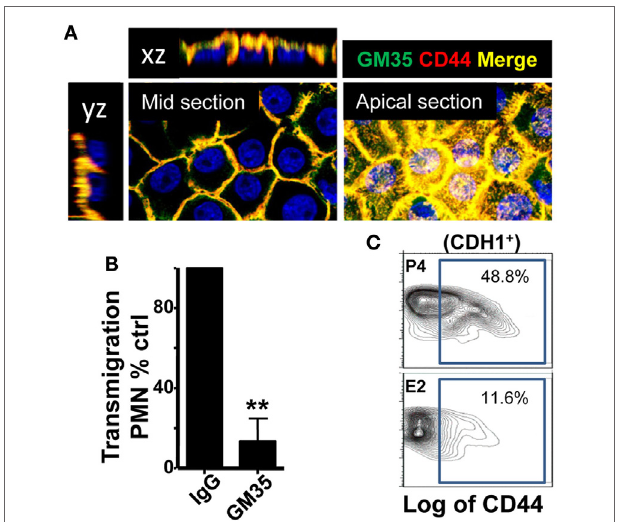
FigUre 7 | CD44 expression in the vaginal cells. (a) Confocal microscopy images of non-permeabilized VK2 monolayers co-stained with GM35 mAb (green) and CD44 (red). A representative picture of three independent tests is shown. (B) Percentage of control PMNs migrated in response to fMLF. Confluent VK2 monolayers were pre-treated apically with isotype control or GM35 mAb before PMNs were added to the basolateral surface. A representative experiment of 3 independent tests is shown. Data are expressed as mean ± SD. ** p < 0.01 Unpaired t test with Welch’s correction. (c) Representative flow cytometry plots of the CD44 expression in the lower female reproductive tract epithelial cells from hormone-treated mice. Data are expressed as percentage of total cells in the gate ( n =